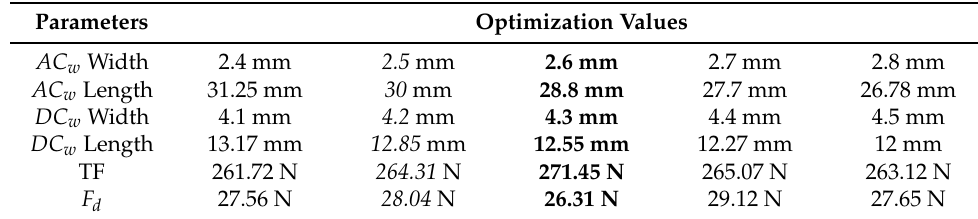
Table 4. Slot area optimization.